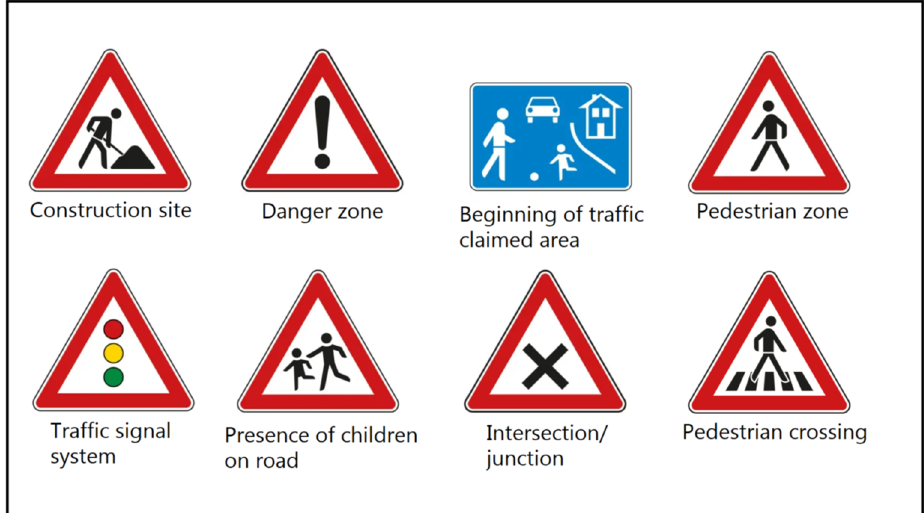
Figure 6. Examples of emergency traffic signs.